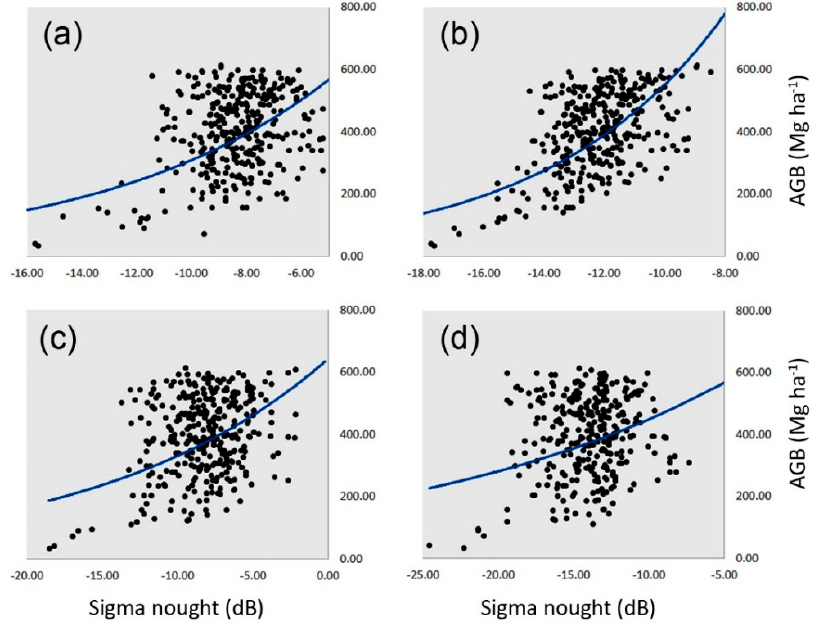
Figure 10. Scatter plots of non-linear correlations between AGB and single polarization of ( a ) PALSAR-2 HH; ( b ) PALSAR-2 HV; ( c ) Sentinel-1A VV; and ( d ) Sentinel-1A VH.